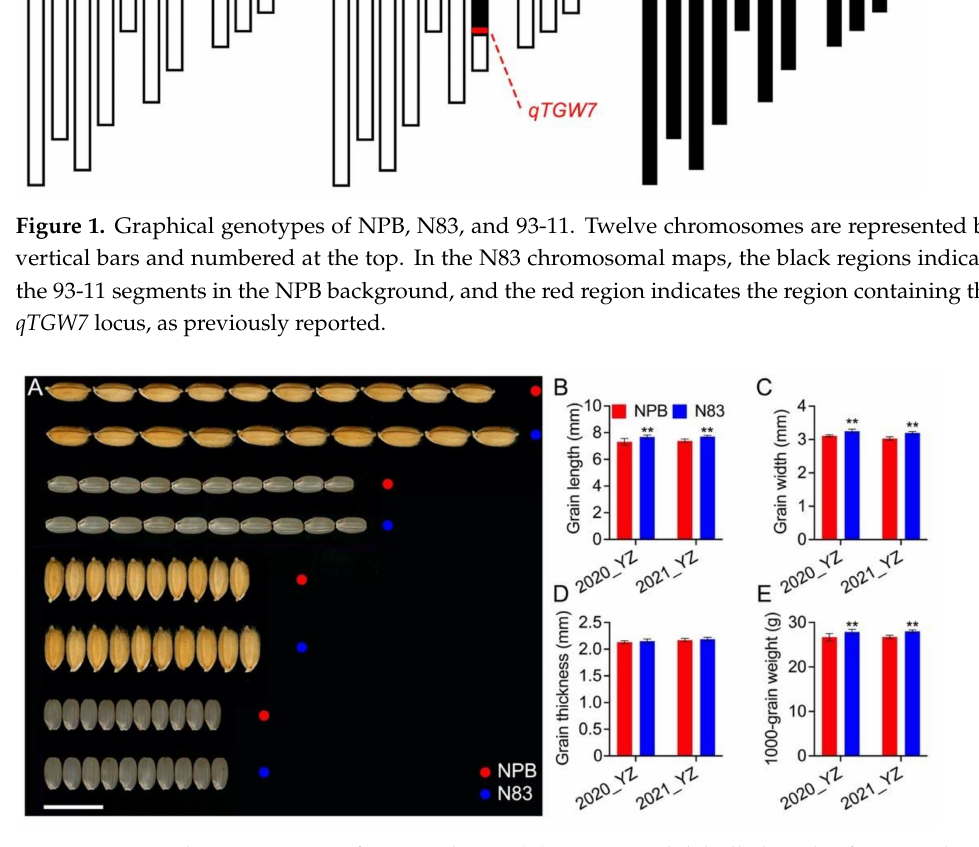
Figure 2. Grain characterization of NPB and N83. ( A ) Mature and dehulled seeds of NPB and N83. Scale bars, 1 cm. Comparison of GL ( B ), GW ( C ), GT ( D ), and TGW ( E ) in two years. Data in ( A – E ) ( n = 20) are means ± SD, ** p < 0.01. Student’s t -test was used to generate the p